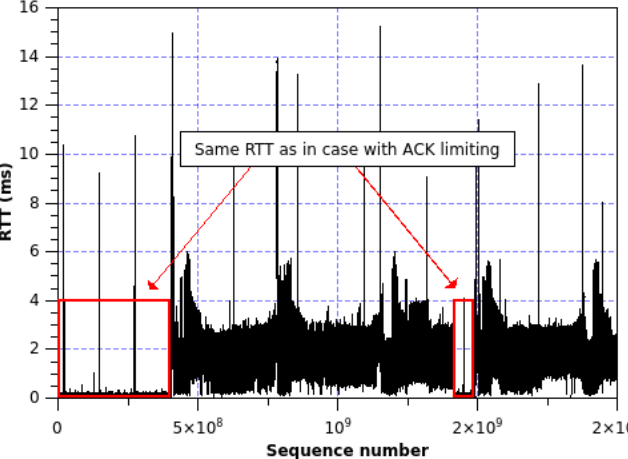
Figure 8. RTT deviation on router with a modified Linux